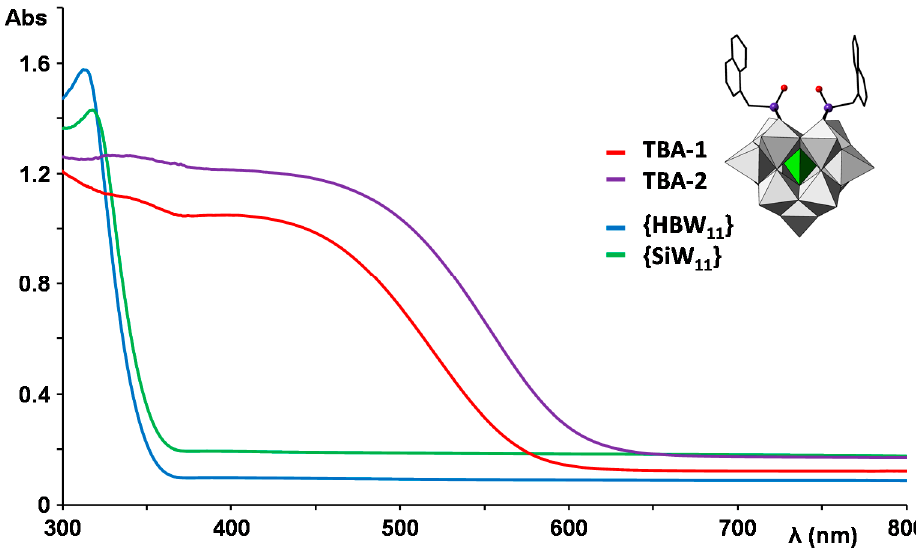
Figure 7. Diffuse Reflectance UV–Vis spectra of powdered crystalline samples of TBA-1 and TBA-2 compared with those of the K 8 [HBW 11 O 39 ]·13H 2 O and K 8 [SiW 11 O 39 ]·13H 2 O precursors.